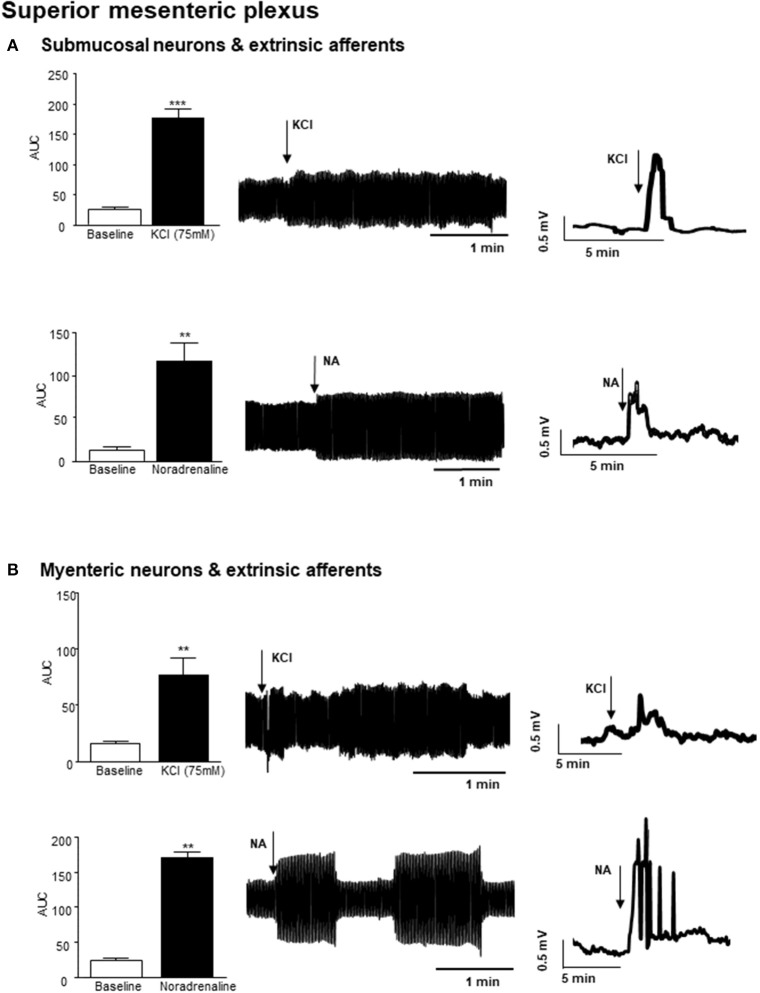
Nerve activity in the superior mesenteric plexus evoked by stimulation of the distal colon. (A) The bar charts and representative filtered and unfiltered traces illustrate nerve activity recorded from the superior mesenteric plexus in response to application of potassium chloride (KCl, 75 mM, n = 3) and noradrenaline (NA, 8 μM, n = 4) to submucosal neurons and afferent nerves in the distal colon. (B) The bar charts and representative filtered and unfiltered traces illustrate nerve activity at the superior mesenteric plexus in response to application of KCl (75 mM, n = 3) and noradrenaline (NA, 8 μM, n = 4) to longitudinal muscle myenteric plexus tissue from the distal colon. **p < 0.01 and ***p < 0.001, respectively.